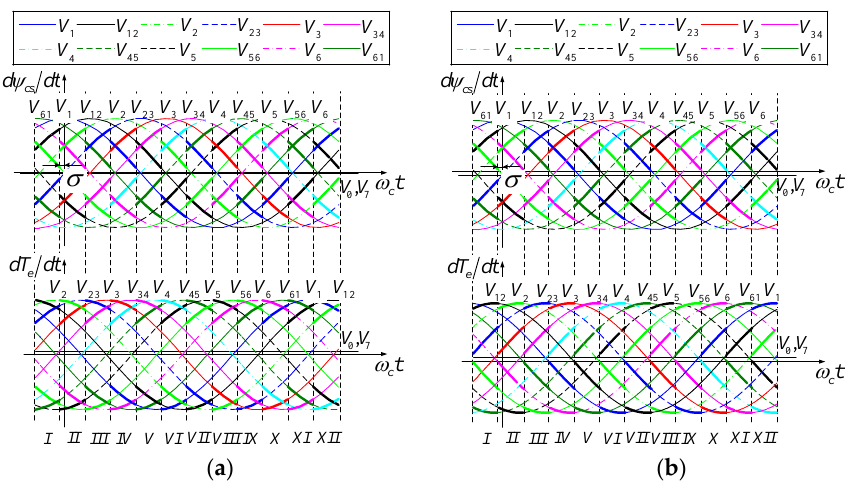
Figure 8. Stator flux of the CM and torque derivative curves. ( a ) Motoring mode ( T e = 30 Nm); ( b ) Motoring mode ( T e = 59 Nm).